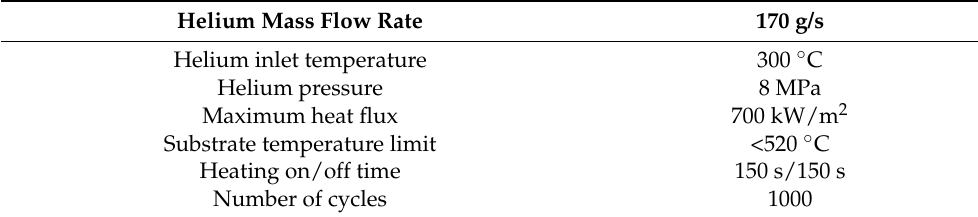
Table 4. Testing parameters of the FG mock-up (see [4] for